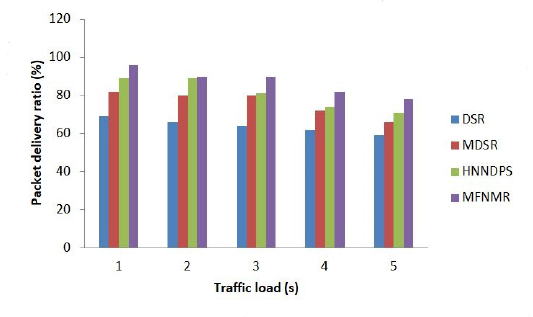
Figure 11. PDR Analysis based on Network Traffic.